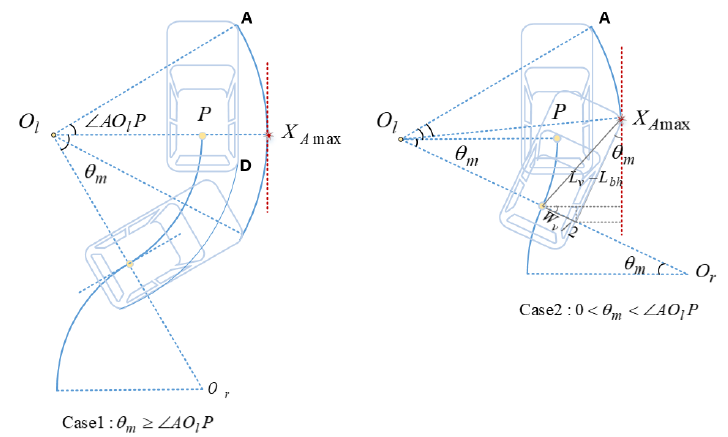
Figure 3. Two cases of S-shaped forward movement. Case 1 θ m ≥ ∠ AO l P : Considering the backward movement from the upper end position P end ( X end , Y end ) to the tangent point, it can be obtained from the analysis of the characteristics of the circle in plane geometry that the right-side furthest position that A can reach is the intersection of the line O l P and the circle C